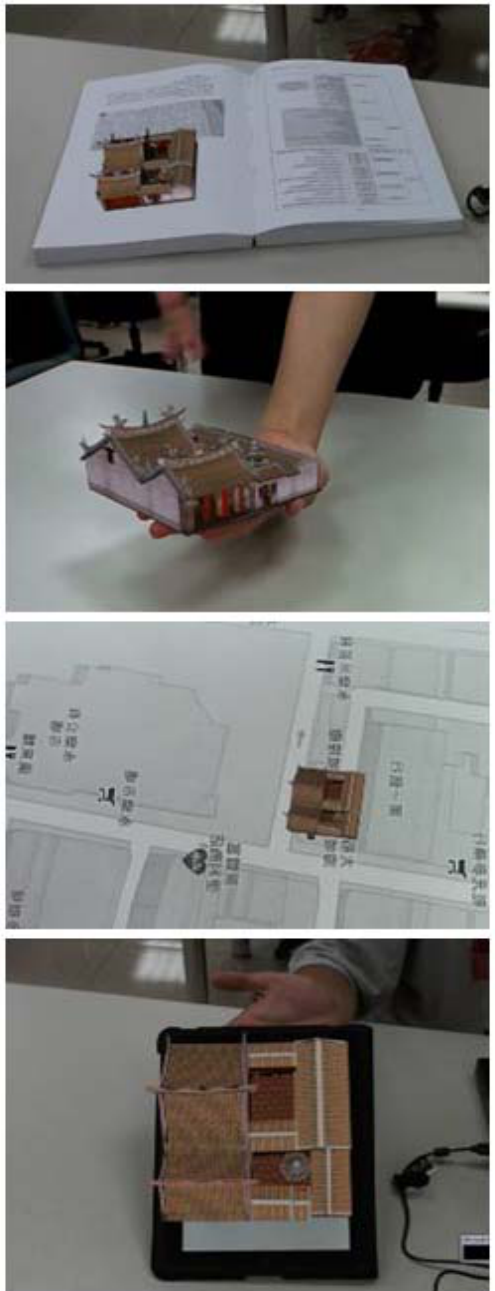
Figure 11. Component dismantling for the Taipei Xia Hai City God Temple Figure 12. Value-added applications of